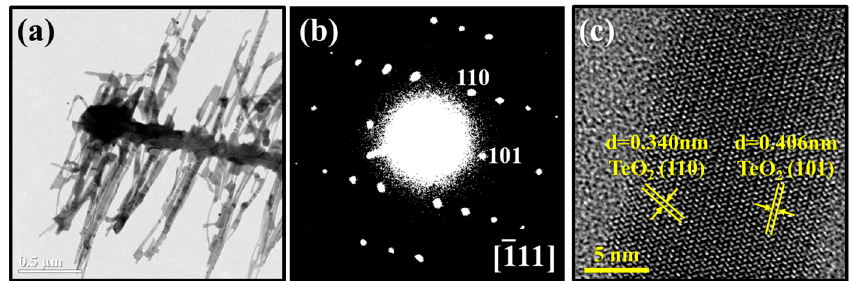
Figure 3. TEM analysis of a TeO 2 branched SnO 2 nanowires with annealing temperature of 370 °C.